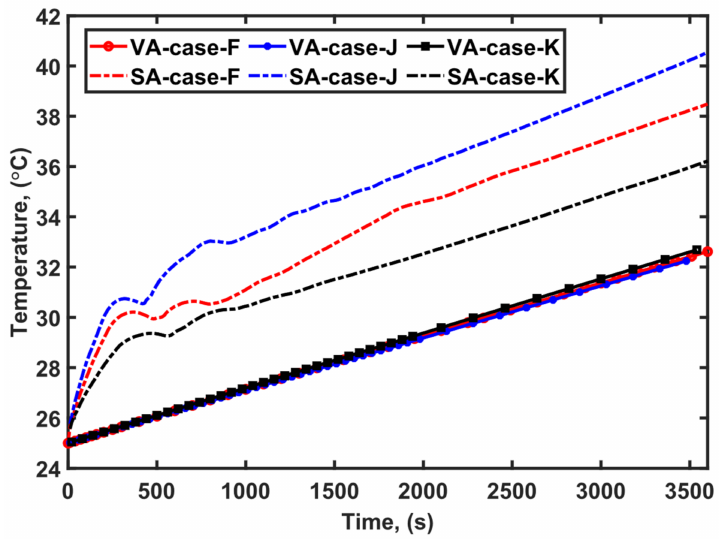
Figure 17. Temporal variation in pool average temperature and surface average temperature for various aspect ratios.